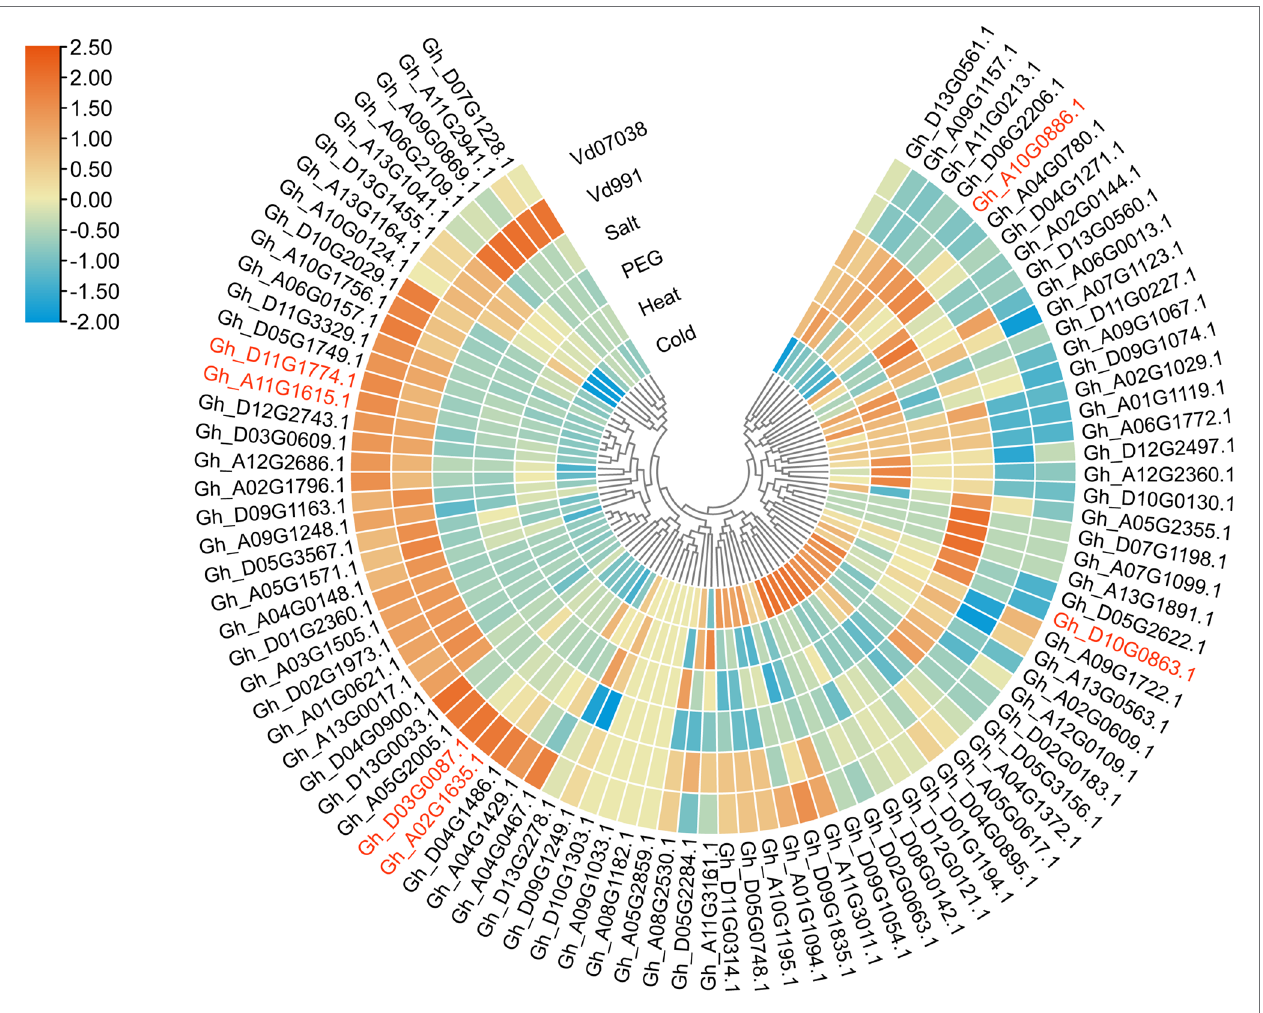
FIGURE 4 | Expression pattern analysis of GhCDPK genes under stress. The expression patterns of GhCDPK genes under abiotic stress were exhibited through the reads per kb per million reads (RPKM) values from the TM-1 transcriptome data. The expression datas of GhCDPK genes under Verticillium dahliae from